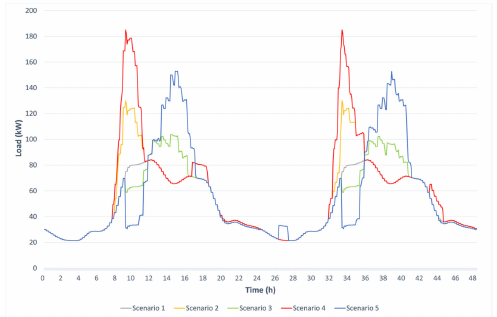
Figure 5. The load profiles of Feeder 067 in all scenarios.